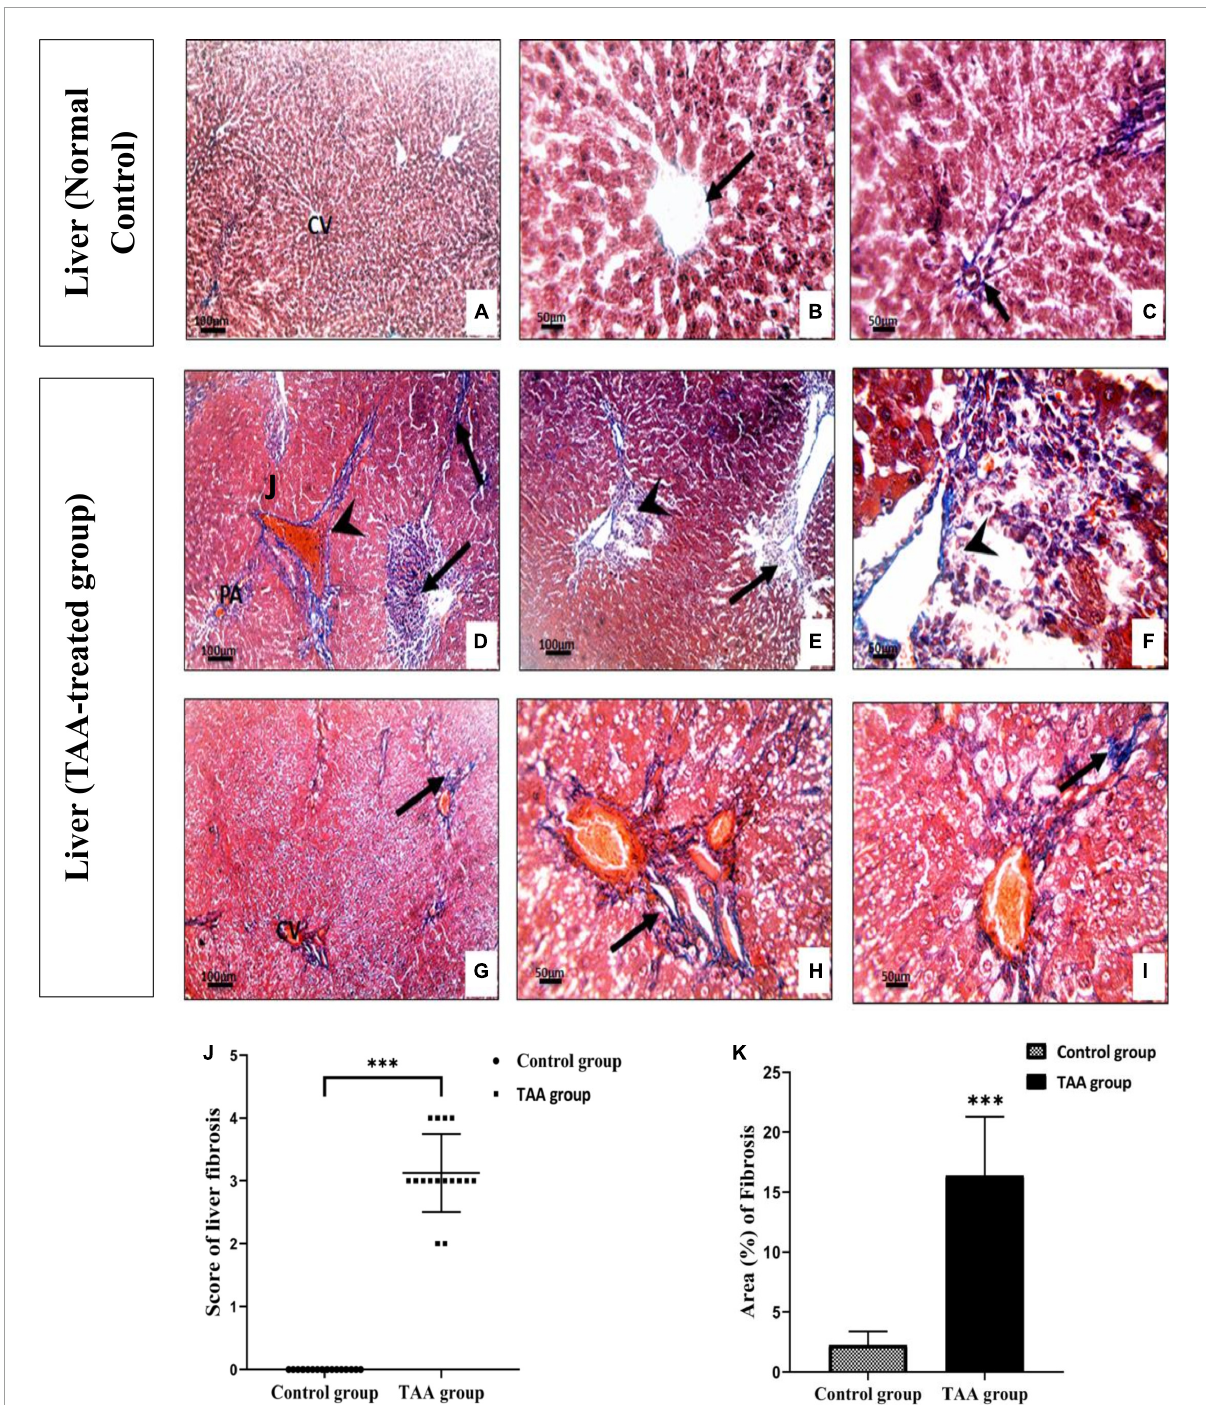
FIGURE3 (A–F) Liver sections of control and TAA-treated groups stained with Masson’s trichrome. (A–C) Control group showing fine scarce collagen fibers (arrow) around central vein (CV) and portal areas (PA). (D–I) TAA-treated groups. (D–F) Excessive blue stained collagen deposition around the PA and dilated blood vessels (arrowhead) and severe fibrosis in liver tissue (arrow). (G–I) Extensive blue collagen deposition around congested CV extending to peripheral liver tissue (arrows) X100 bar 100, X 400 bar 50. (J) The scores of the degree of liver fibrosis. Data are expressed as mean ± SD. ∗∗∗ p < 0.001 vs. control group. (K) The area of collagen fibers in the liver (%). Data are displayed as mean ± SD. ∗∗∗ p < 0.001 vs. control